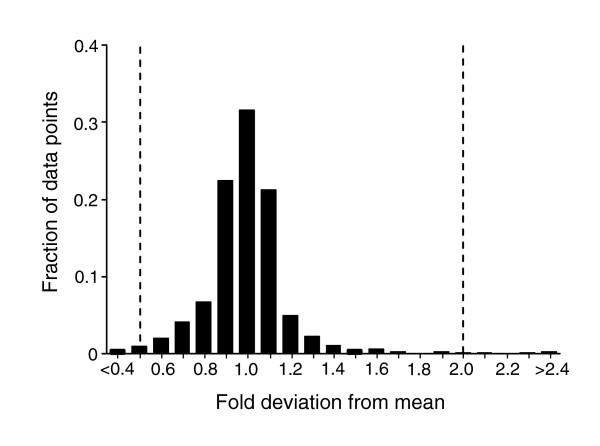
Reproducibility of the method. Mean expression levels for each transcript under each condition were computed and the deviation of each individual data point from its corresponding mean was recorded. A histogram of the fraction of data points in each of 12 bins of fold deviation values is shown. This plot represents 1,800 data points (two conditions × 90 transcripts × 10 replicates).